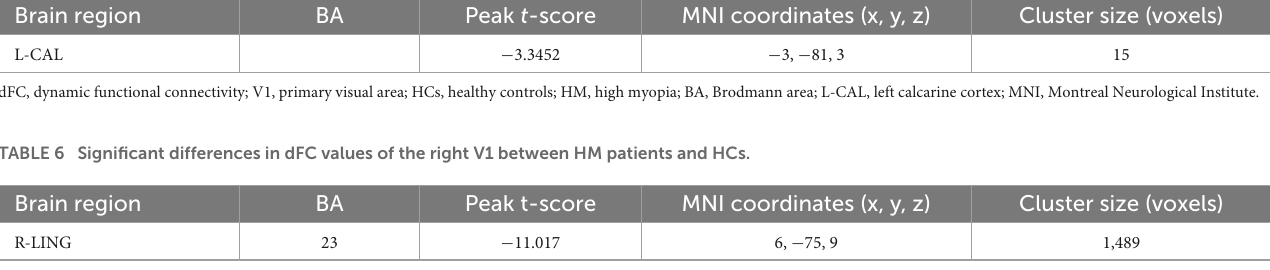
TABLE 5 Significant differences in dFC values of the left V1 between HM patients and HCs. Brain region BA Peak t -score